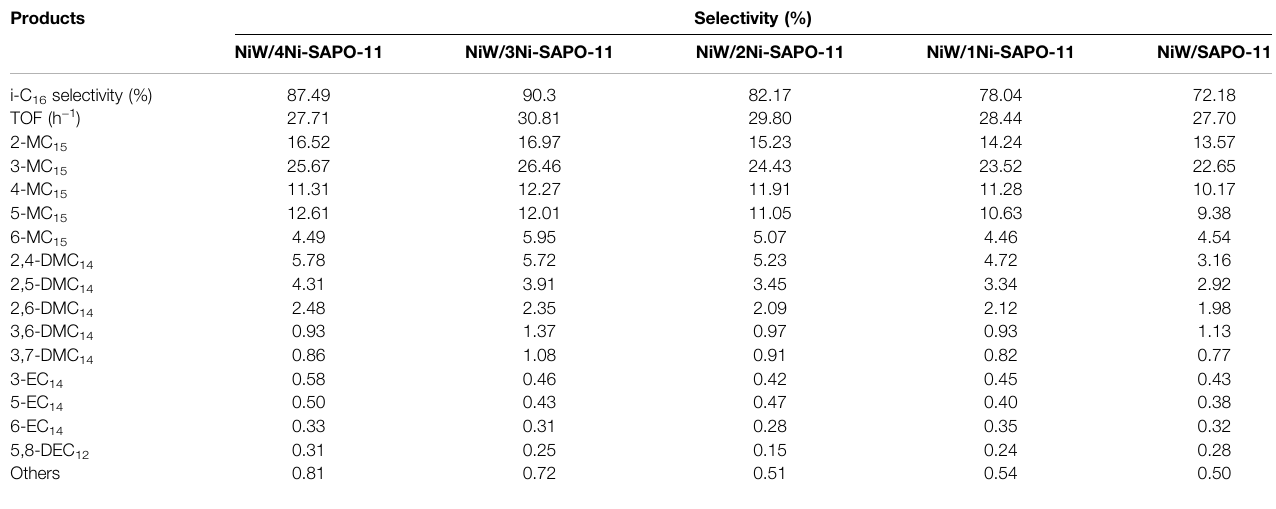
TABLE 7 | Isomer distributions and TOF values of n-C 16 hydroisomerization over the different catalysts at 340 ° C. Products Selectivity (%) NiW/4Ni-SAPO-11 NiW/3Ni-SAPO-11 NiW/2Ni-SAPO-11 NiW/1Ni-SAPO-11 NiW/SAPO-11 i-C 16 selectivity